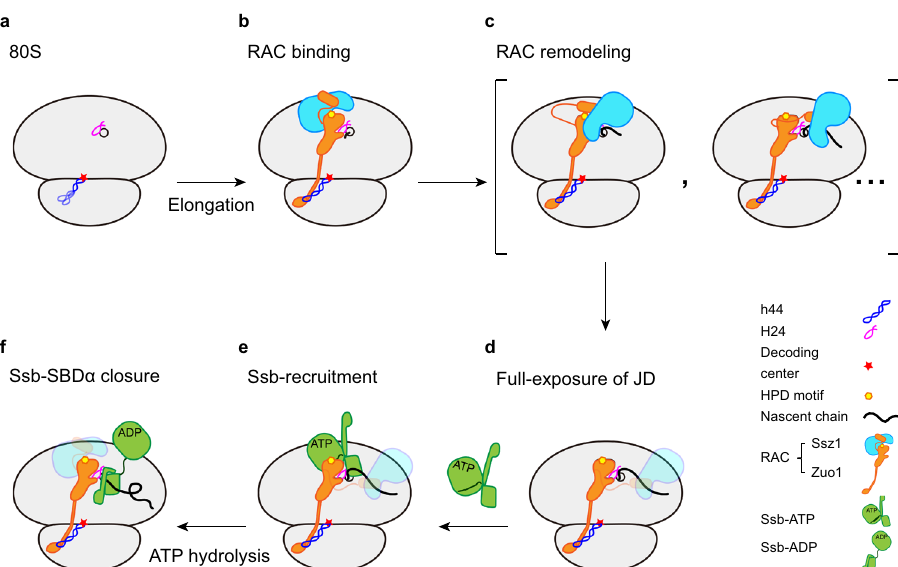
Fig. 7 Model of RAC-Ssb actions in co-translational folding. a , b RAC binds to the 80S ribosome, and through interactions of Zuo1 ZHD with H24-eL31- H101 (H24 as a key anchor point) on the 60S subunit and Zuo1 CTD with ES12-h44 on the 40S subunit. The JD of Zuo1 is initially covered by Ssz1 SBD. During translation elongation, the nascent chain emerges from the PTE ( ∼ 5 residues) and starts to interact with the hydrophobic patch on the N-terminus of ZHD- α 3. c The elongated nascent chain triggers extensive conformational remodeling of RAC and Ssz1 is relocated to the PTE side of Zuo1 JD. A handover of substrate from Zuo1 to Ssz1 also occurs, which leads to further weakening of the Ssz1:Zuo1 interface. d The nascent chain competitively binds to Ssz1 SBD and thus disrupts the interface between Zuo1 and Ssz1 to mobilize Ssz1, resulting in a full exposure of the HPD motif. e Ssb-ATP recognizes Zuo1 JD and thus is recruited to the translating ribosome, with its SBD facing the PTE. f The nascent chain is handed over from RAC to Ssb. The ATP- hydrolysis of Ssb takes place, facilitated by Zuo1 JD, and Ssb transits to the ADP and high-af fi nity substrate-bound